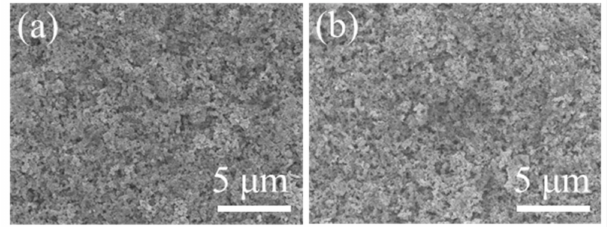
Figure 7. SEM images of the cathodic catalyst layer surface ( a ) before and ( b ) after 64 h durability